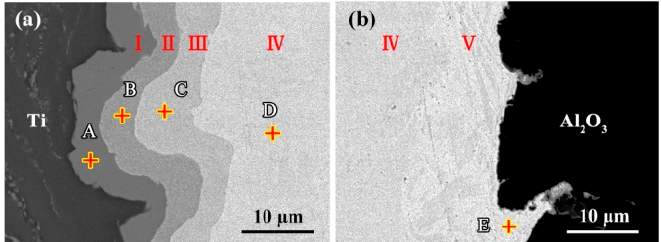
Figure 3. Microstructure of the titanium/Au/Al 2 O 3 joint at a high magnification: ( a ) the titanium/brazing seam interface; ( b ) the brazing seam/Al 2 O 3 interface.